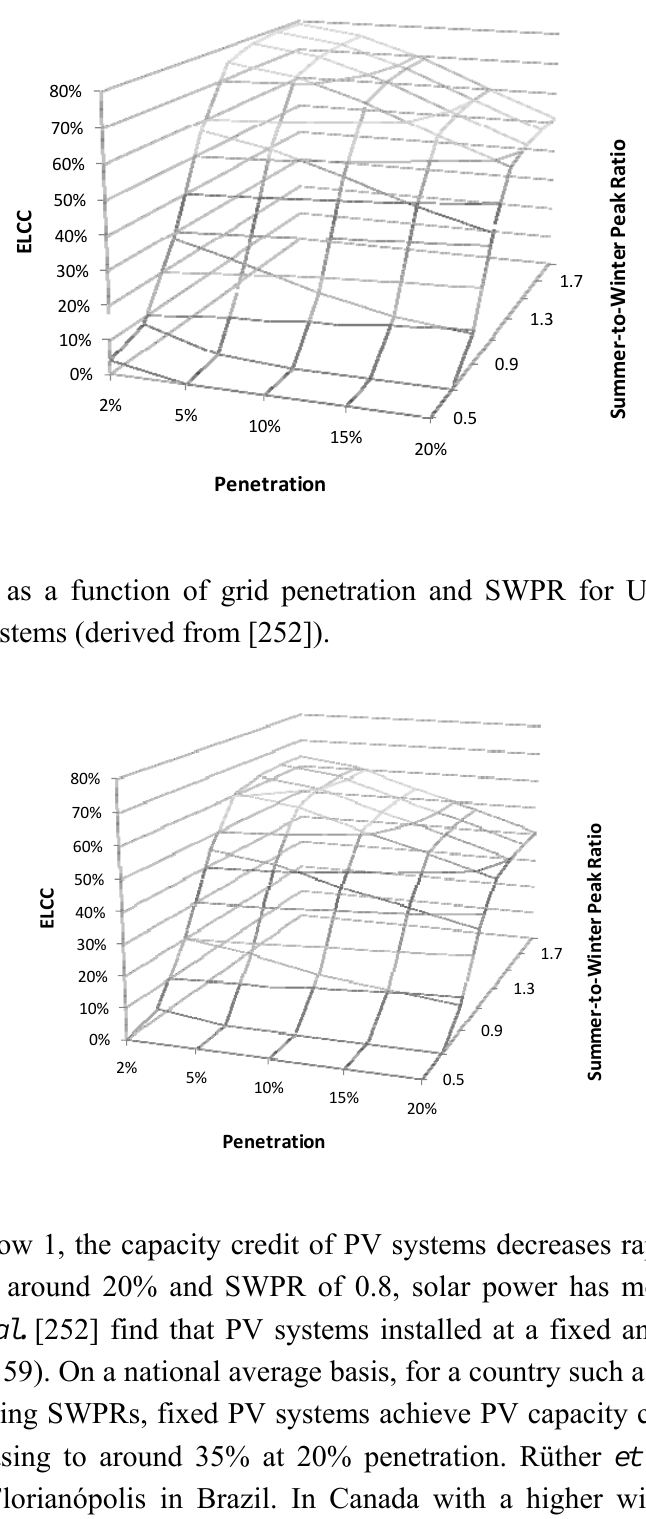
Figure 58. ELCC as a function of grid penetration and SWPR for US 2-axis tracking PV systems (derived from [252]).